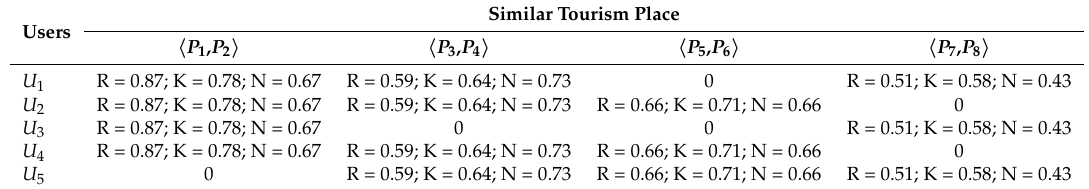
Table 1. The activities history of the